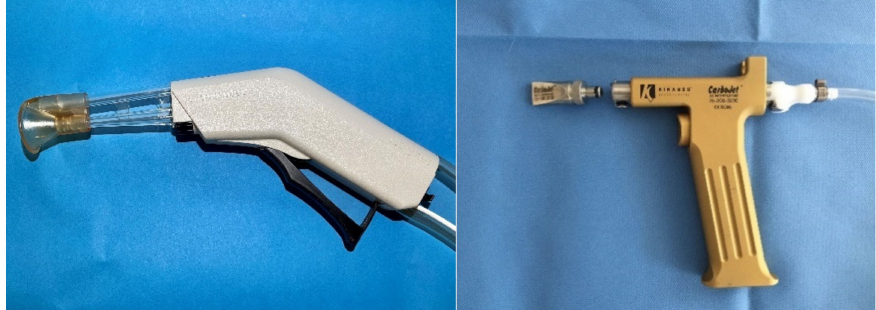
Figure 1. ( left ) Handpiece of InterPulse by Stryker. ( right ) Handpiece of CO 2 lavage CarboJet by KINAMED.